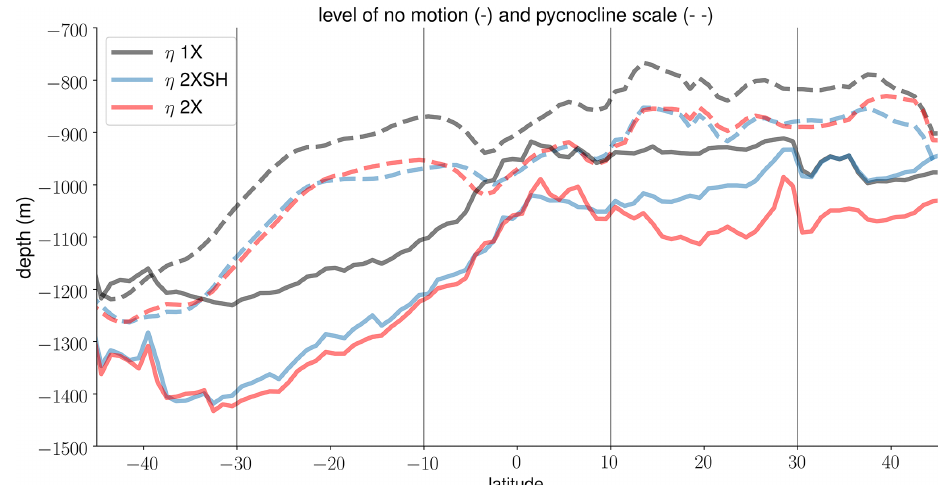
Figure 4. The time-mean (1991–2010) wind forcing dependencies of the level of no motion η ψ (solid) and the pycnocline scale η ρ (dashed) with respect to the 1X experiment (black), the 2XSH experiment (blue), and the 2X experiment